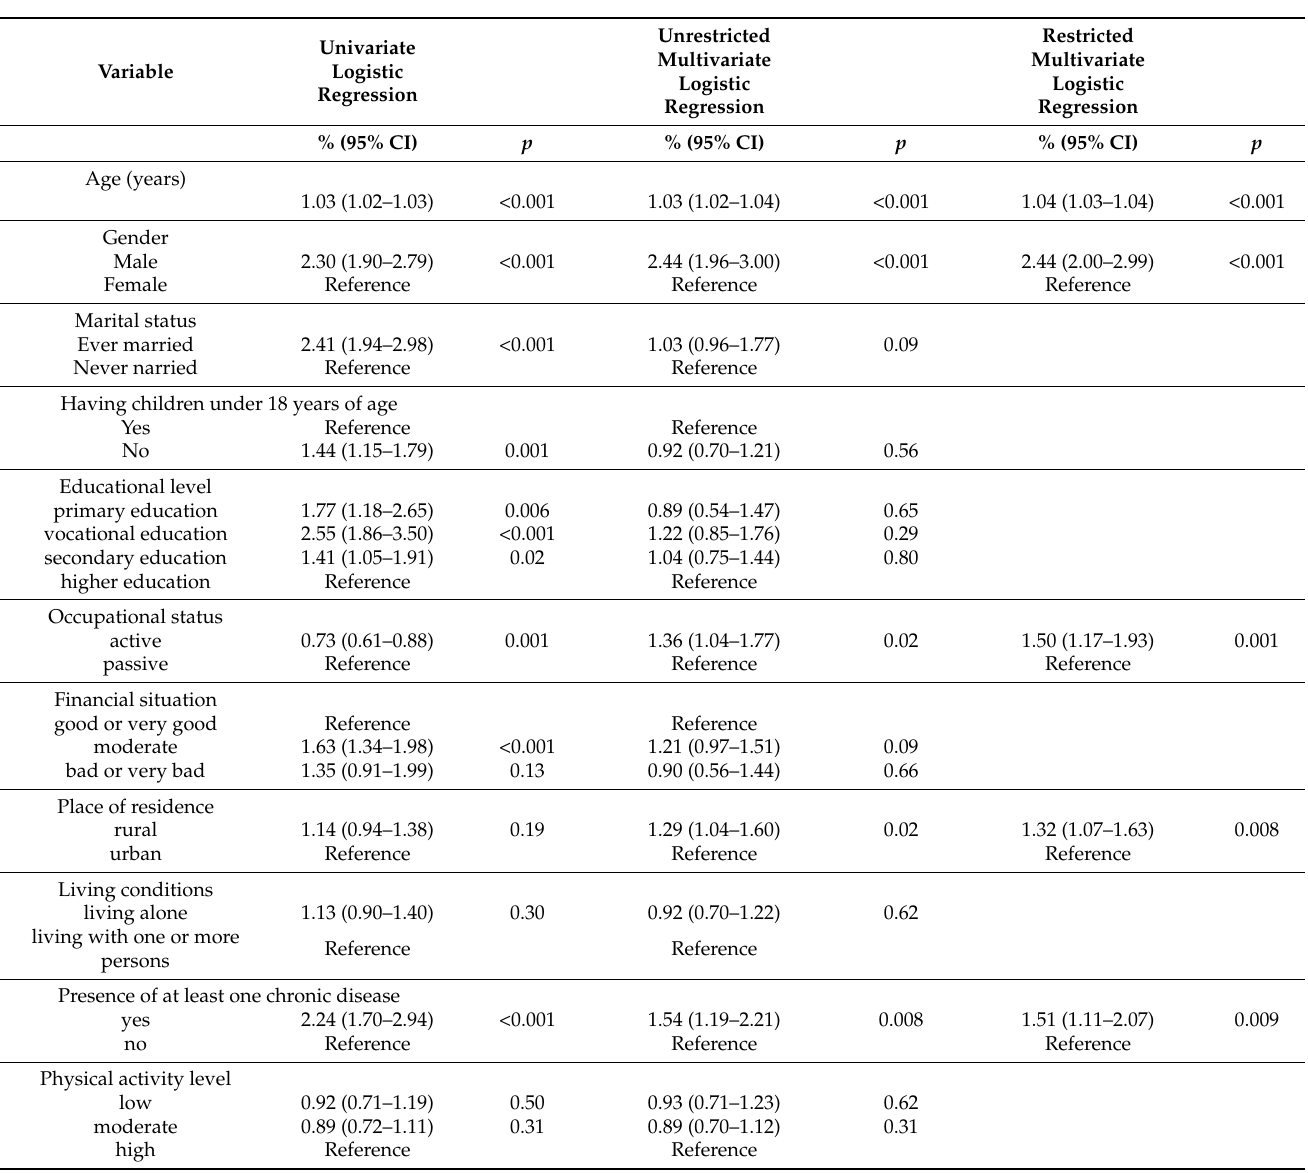
Table 4. Odds ratios (OR) and 95% confidence intervals (CI) for overweight and obesity com- pared with normal weight to selected sociodemographic factors in a representative sample of adults in